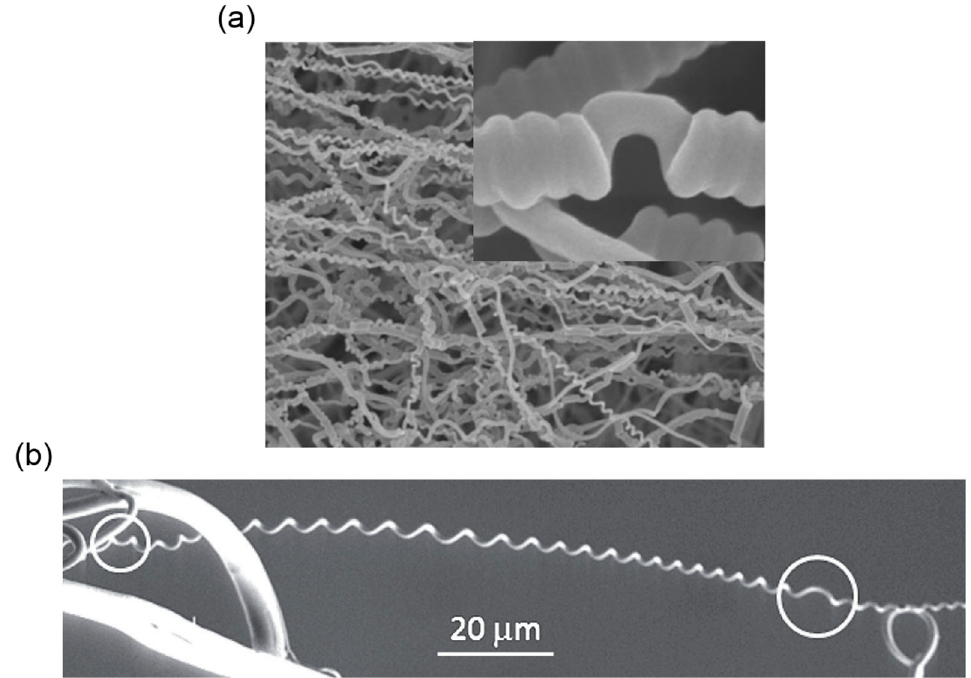
Figure 17. The electrospun fibers coil themselves with perversions. ( a ) Scanning electronic microscopy (SEM) image of TPU/Nomex nanofibers produced from side-by-side electrospinning; The inset shows a perversion inside the nanospring; ( b ) SEM image of the electrospun cellulose fibers, the perversion is underscored with white circles. ( a ) is from [127], reprinted with permission, copyright © 2009, John Wiley and Sons; ( b ) is from [128], reprinted with permission of Royal Society of Chemistry.